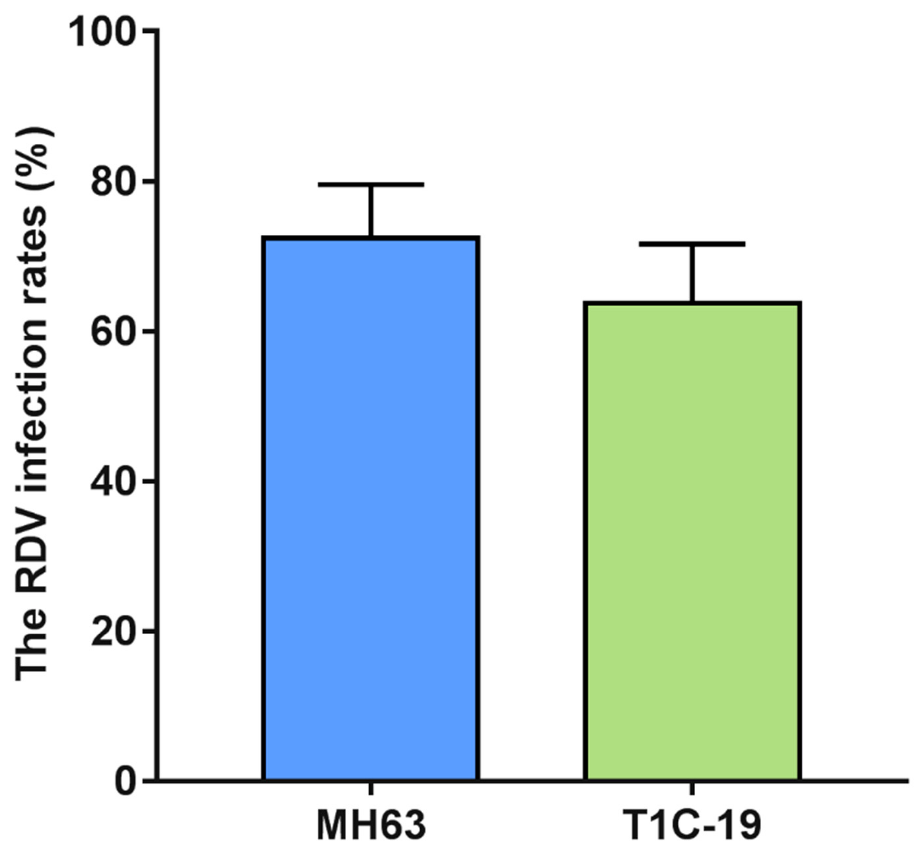
Figure 5. The RDV infection rates between Cry1C and MH63 rice plants. The RDV infection rates were analyzed using Student’s t -test. Values are mean ± standard error (n = 3.